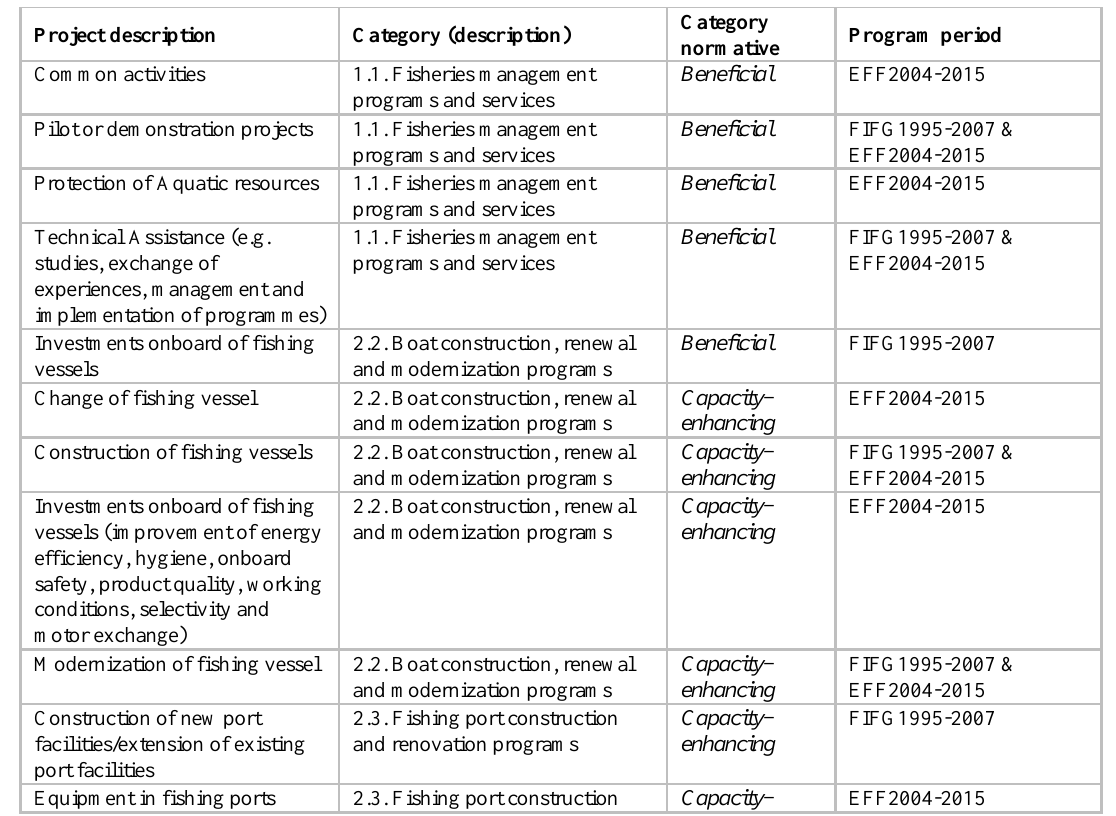
Table A1.3. Grants to the fishing industry and fisheries management from the European fisheries funds 1995 – 2014 and their categorization into descriptive and normative categories according to Sumaila et al. 2010. Abbreviations for the program periods: FIFG: Financial Instrument for Fisheries Guidance, EFF: European Fisheries